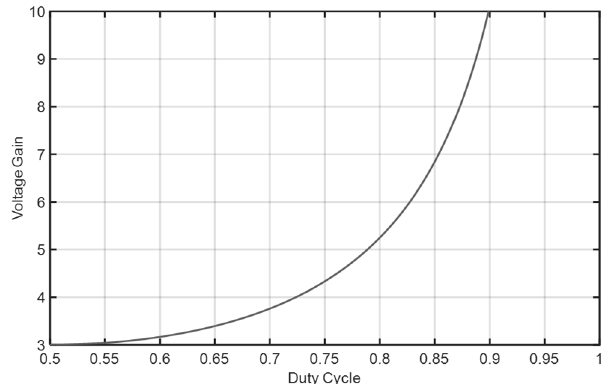
Figure 3. Voltage gain of FIBC for different values of 𝑑 .